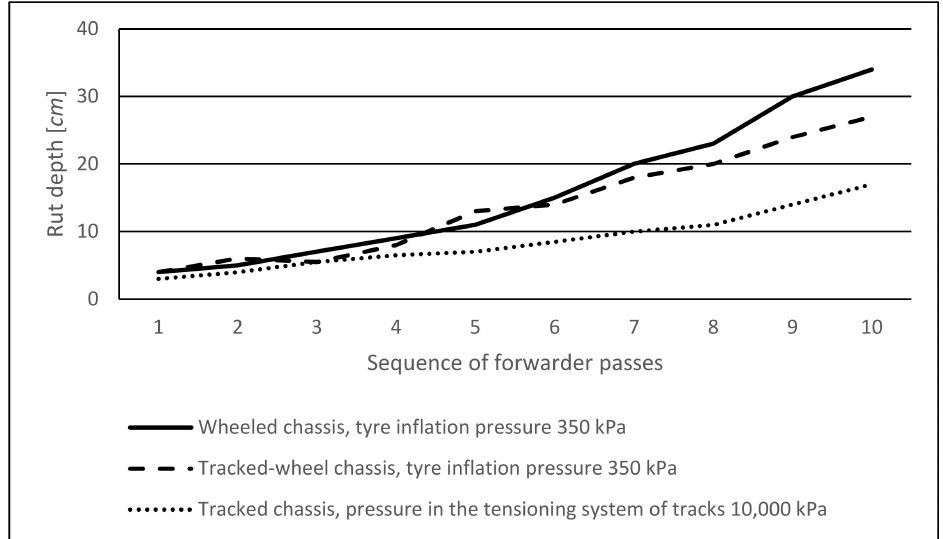
Figure 10. Driving track deepening in the soil profile after the pass of wheeled, tracked-wheel, and tracked type of the loaded